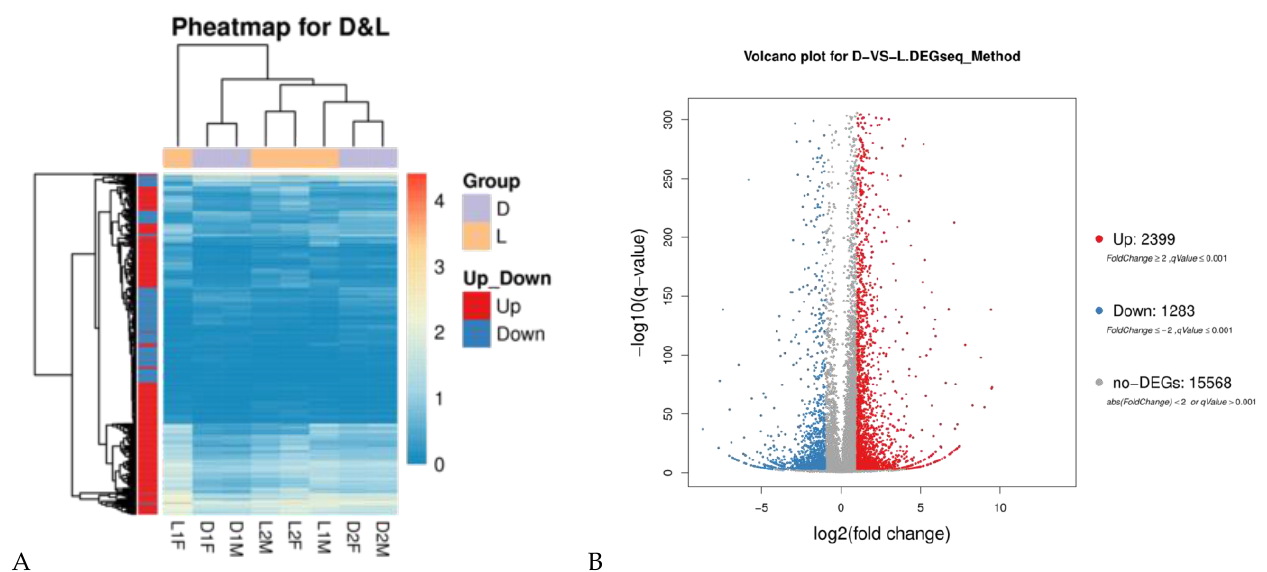
Figure 1. Transcriptome analysis of genes between the Duroc pig and Luchuan pig. ( A ) Heatmap analysis of gene expression based on the log10 ratio fold-change data. The horizontal axis represents samples, and the vertical axis represents differentially expressed genes that are upregulation and downregulation in red color and blue color, respectively. The color scale indicates gene expression based on log10 ratio fold-change data. ( B ) Volcano plot of significant differences in gene expression between the Duroc pig and Luchuan pig. Red spots represent the upregulation of genes, and blue dots are downregulated genes. Log2 FC indicates the fold change between the Duroc pig and the Luchuan pig. The longitudinal coordinates indicate the natural logarithm of the magnitude of the control groups. The longitudinal coordinates indicate the magnitude of differences at the transcriptional level.